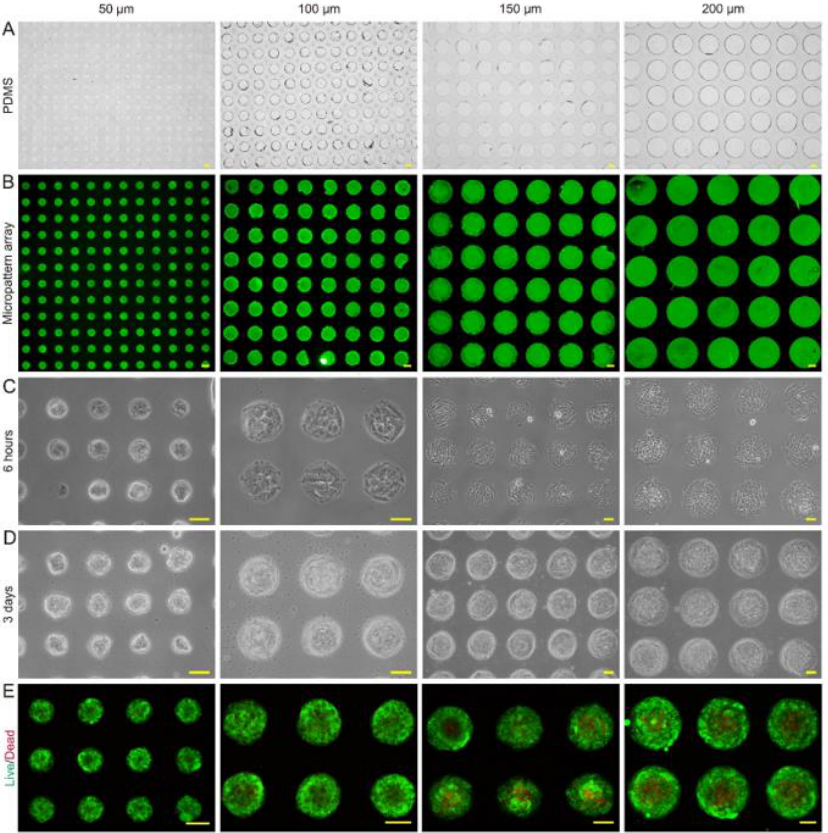
Figure 3. Fabrication of micropattern arrays and the formation of CD31+ HemEC microtumors. Micropattern arrays ( A ) in bright field and ( B ) in fluorescence light from PDMS seals with 50, 100, 150, and 200 µ m diameters. ( C ) The CD31+ HemECs cultured on micropattern arrays with different diameters at 6 h after cell seeding. ( D ) The CD31+ HemECs formed microtumors with different diameters at day 3 after cell seeding. ( E ) Live/dead staining of CD31+ HEC microtumors. Scale bars = 50 µ